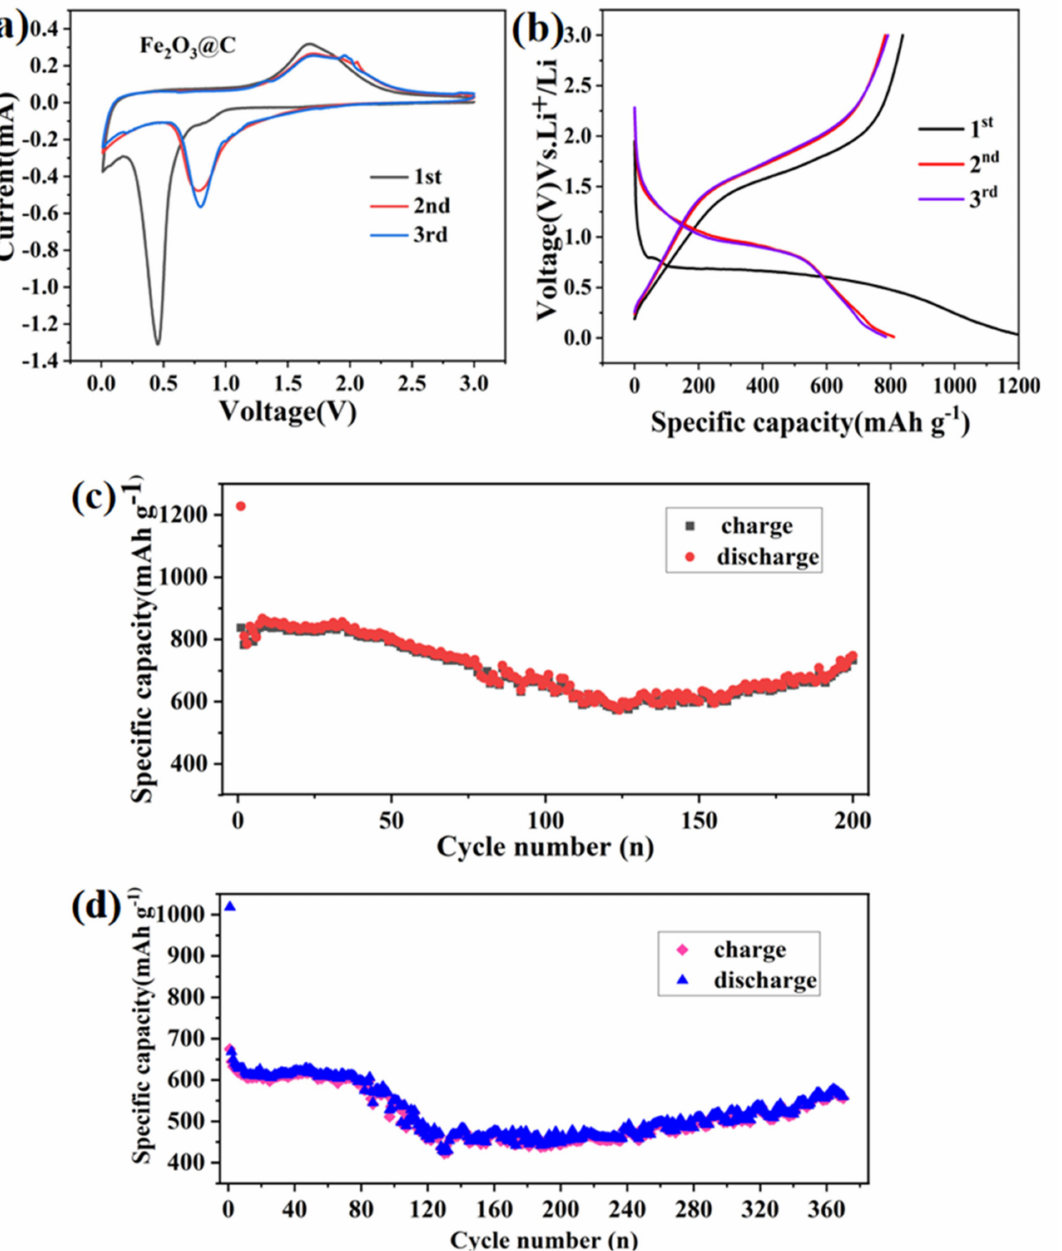
Figure 8. Electrochemical properties of the Fe 2 O 3 @C electrode: ( a ) Cyclic voltammograms between 0.01 and 3 V at a potential sweep rate of 0.1 mV s − 1 . ( b ) Discharge/charge profiles at 0.2 A g − 1 , and ( c , d ) Cycling performance at 0.2 A g − 1 and 0.5 A g − 1 ,